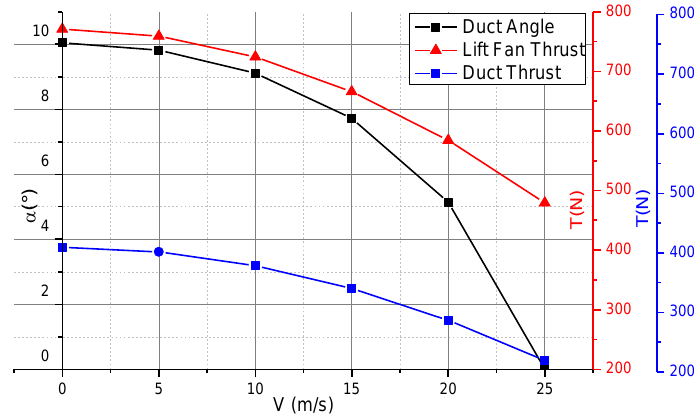
Figure 11. Lift fan and lift duct state curve when pitch angle is 7.21 ◦ .